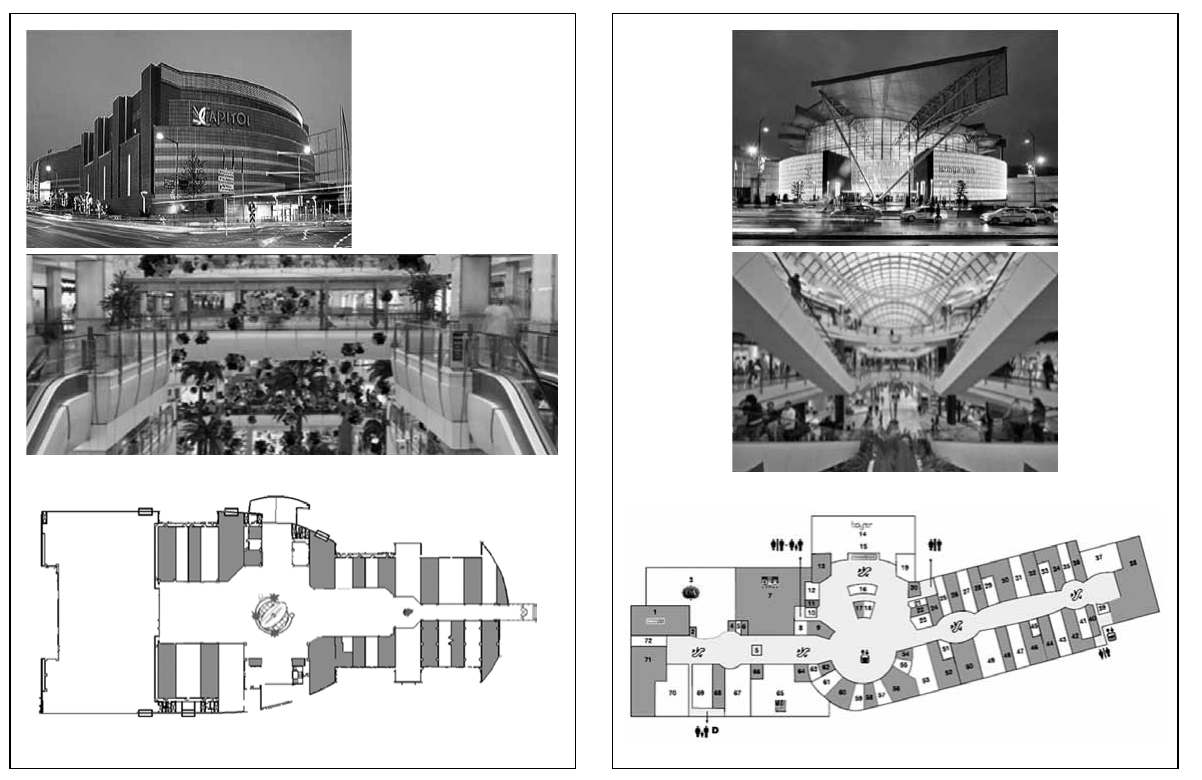
fig. 5. Capitol Shopping Mall Plan-Exterior-Interior, Istanbul fig. 6. Istinye park Shopping Mall Plan-Exterior-Interior,